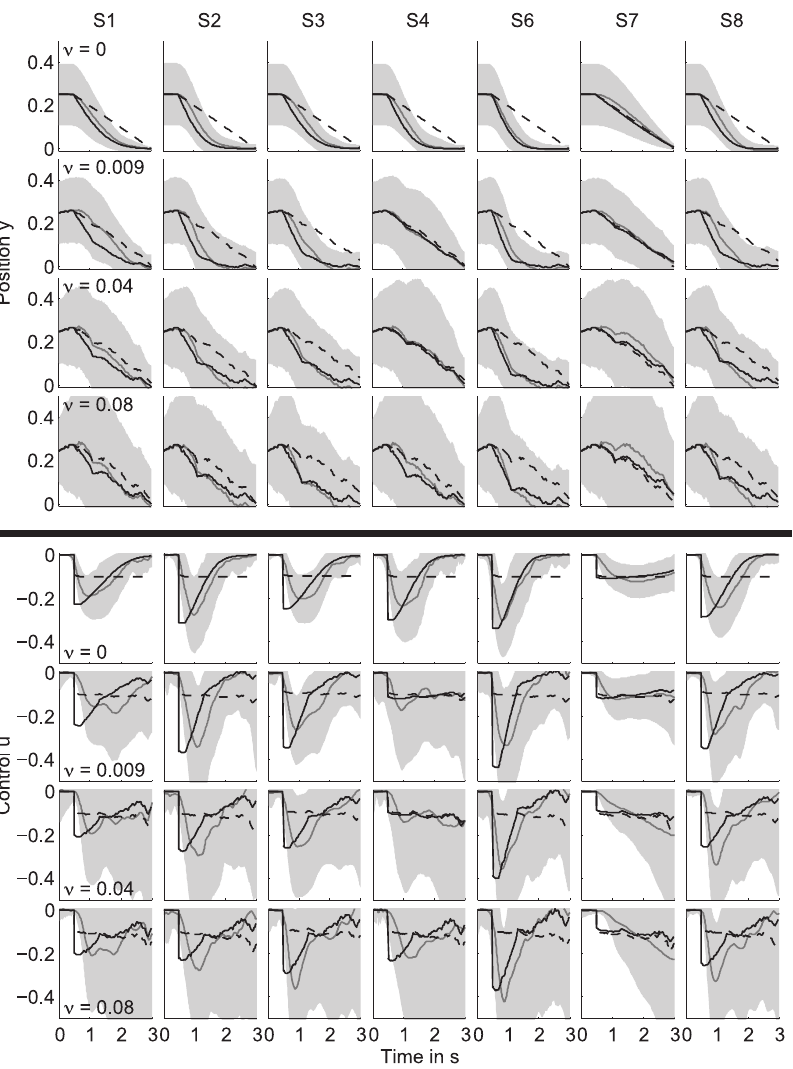
Figure 2. Behavior and model predictions for the one-target task. Top panels: average ball position displayed as mean (gray solid line) and standard deviation (gray shaded area) for all noise amplitudes (rows) and subjects (columns). The black dashed and solid line represent the average fit of the standard model and the extended model, respectively. Bottom panels: same for the control signal. Subject S5 was discarded (see Methods ).